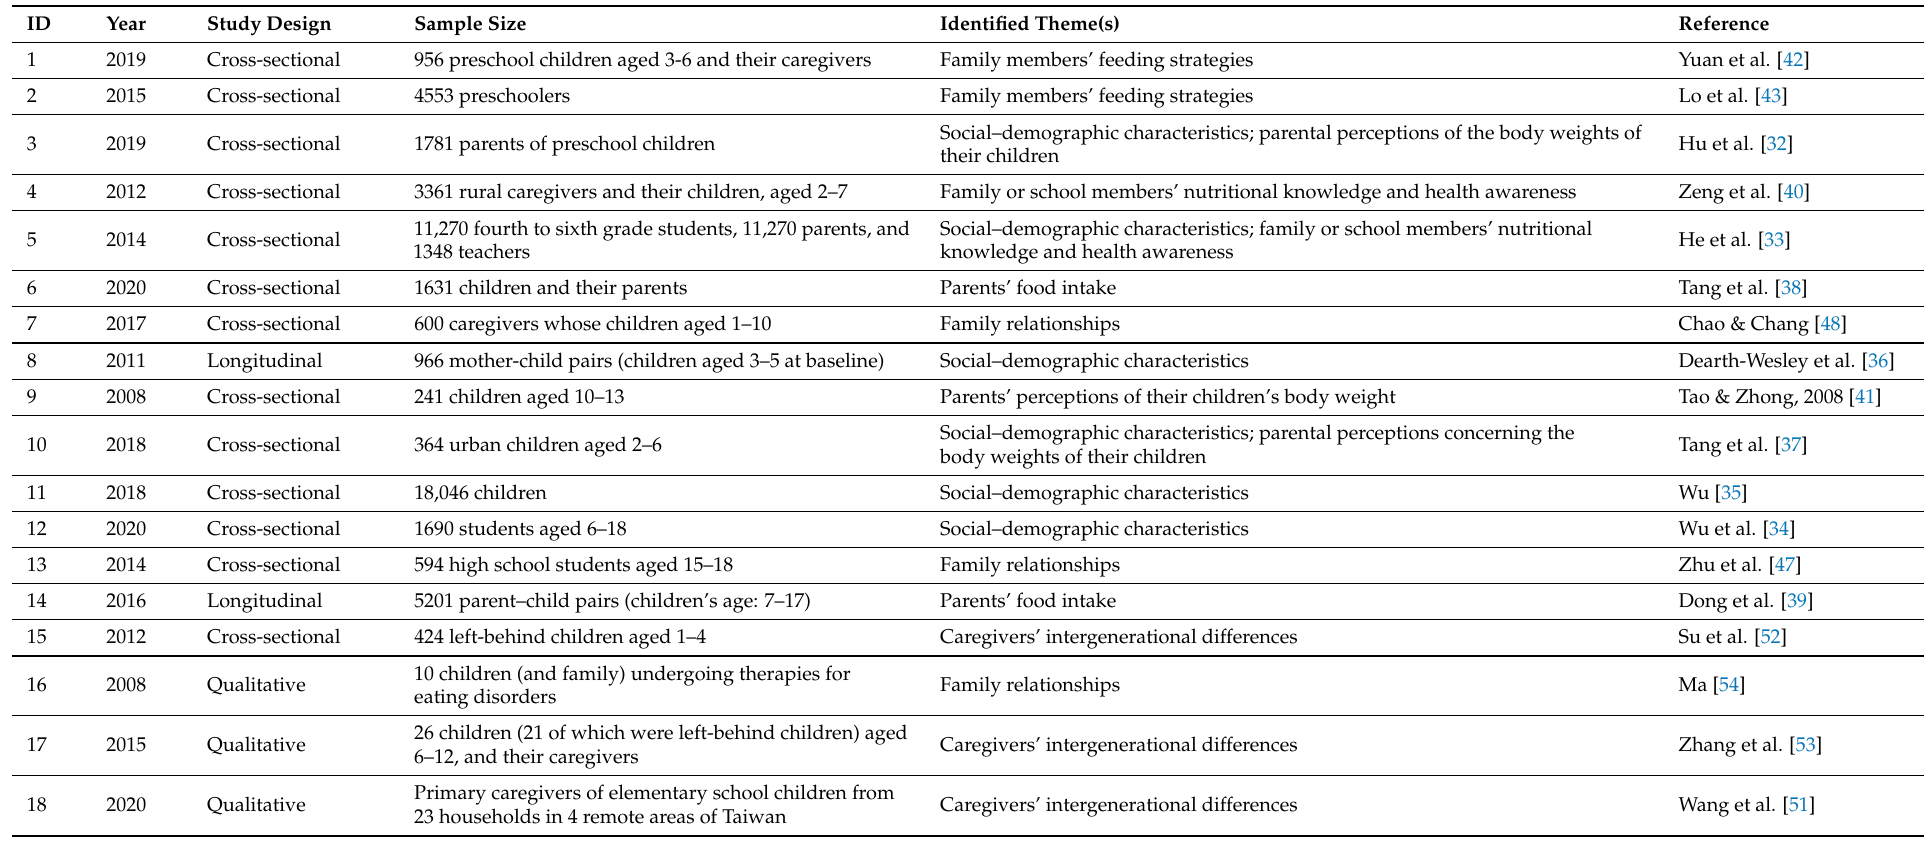
Table 2. Summary of the eligible